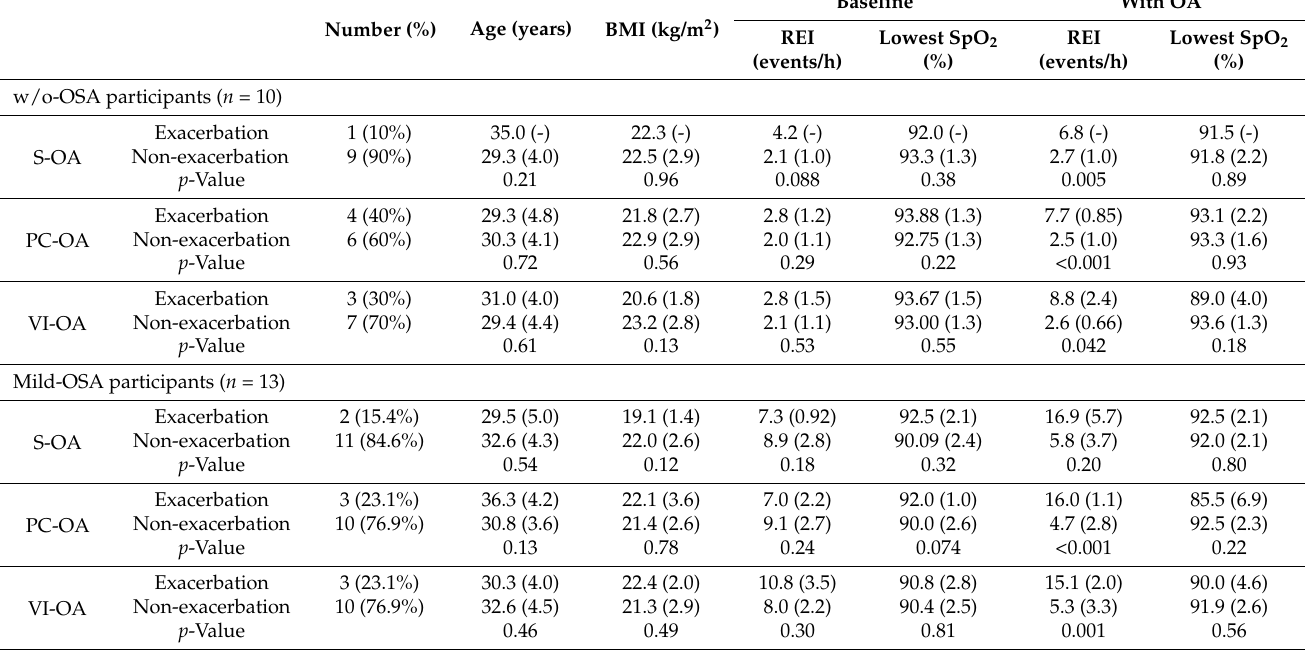
Table 2. Comparison of age, BMI, and respiratory variables in exacerbation and non-exacerbation groups by wearing OA.